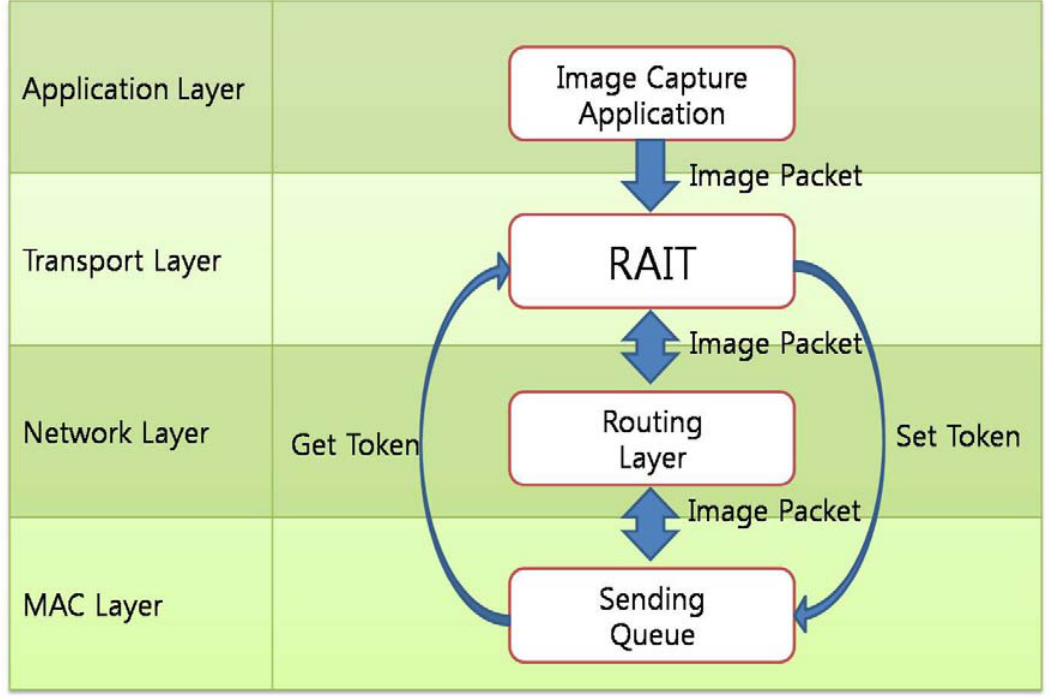
Figure 5. Cross-layer design. RAIT controls the sending queue with Set Token and Get